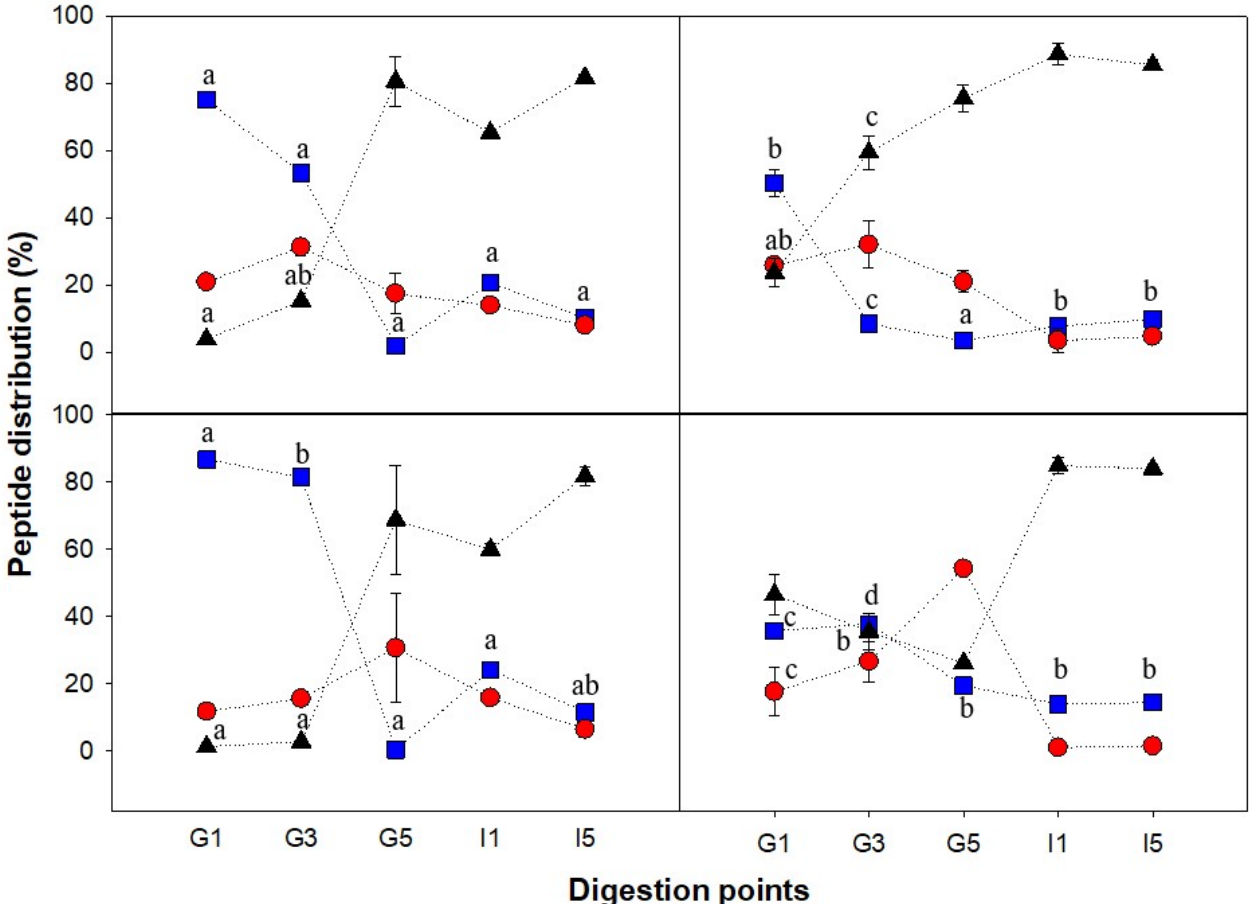
Figure 5. Molecular weight distribution of the peptides present in the soluble fraction of the four potato protein isolate (PoPI) samples. Suspension (a), gel (b), foam (c), heat-set foam (d). Three different Mw ranges are presented: 80–30 kDa (squares), 30–1 kDa (circles), <1 kDa (triangles). Bars represent standard deviation. Letters indicate differences within the same Mw population. Lines are drawn to guide the eye. Gastric stages: G1 (8.26 min), G3 (24.78 min), G5 (41.30 min), and corresponding intestinal points (I1 and I5).